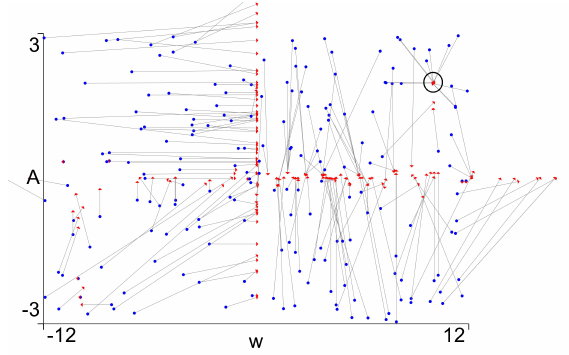
Figure 4: The Random initial guess method is used to test for local minima when estimating the amplitude ( A ) and frequency ( w ) of a sim- ulated sine wave with added noise. Out of K = 200 repeated optimisations, only 12 cor- rectly find the true parameters θ ∗ (marked by a black circle in the figure). Blue dots mark the randomised initial guess and red dots mark the parameters obtained after op-